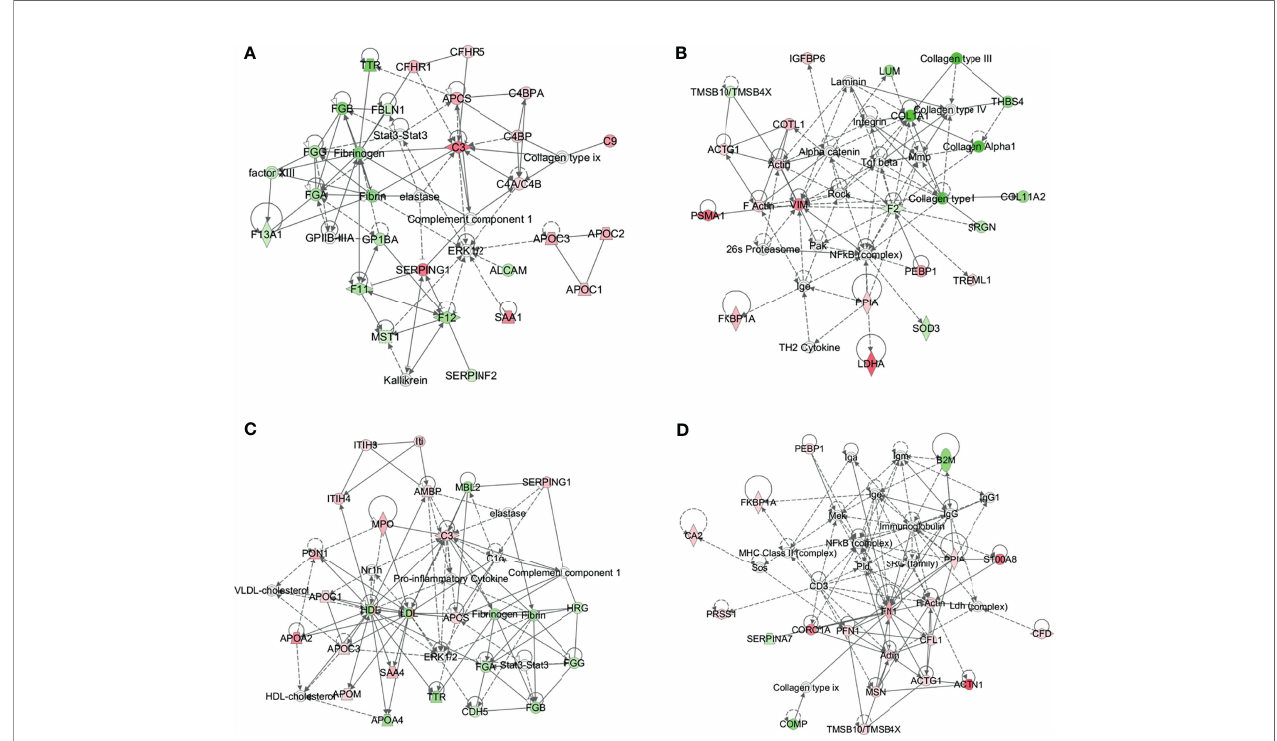
FIGURE 5 | Protein – protein interaction (PPI) networks based on the differentially expressed proteins by IPA. The 2 representative PPI networks based on the differentially expressed proteins in B-NHL compared with the control (A, B) . The 2 representative PPI networks based on the differentially expressed proteins in T- NHL compared with the control (C, D) . Red denotes upregulated proteins, while green denotes downregulated proteins. Solid and dashed lines represent direct and indirect interactions, respectively.